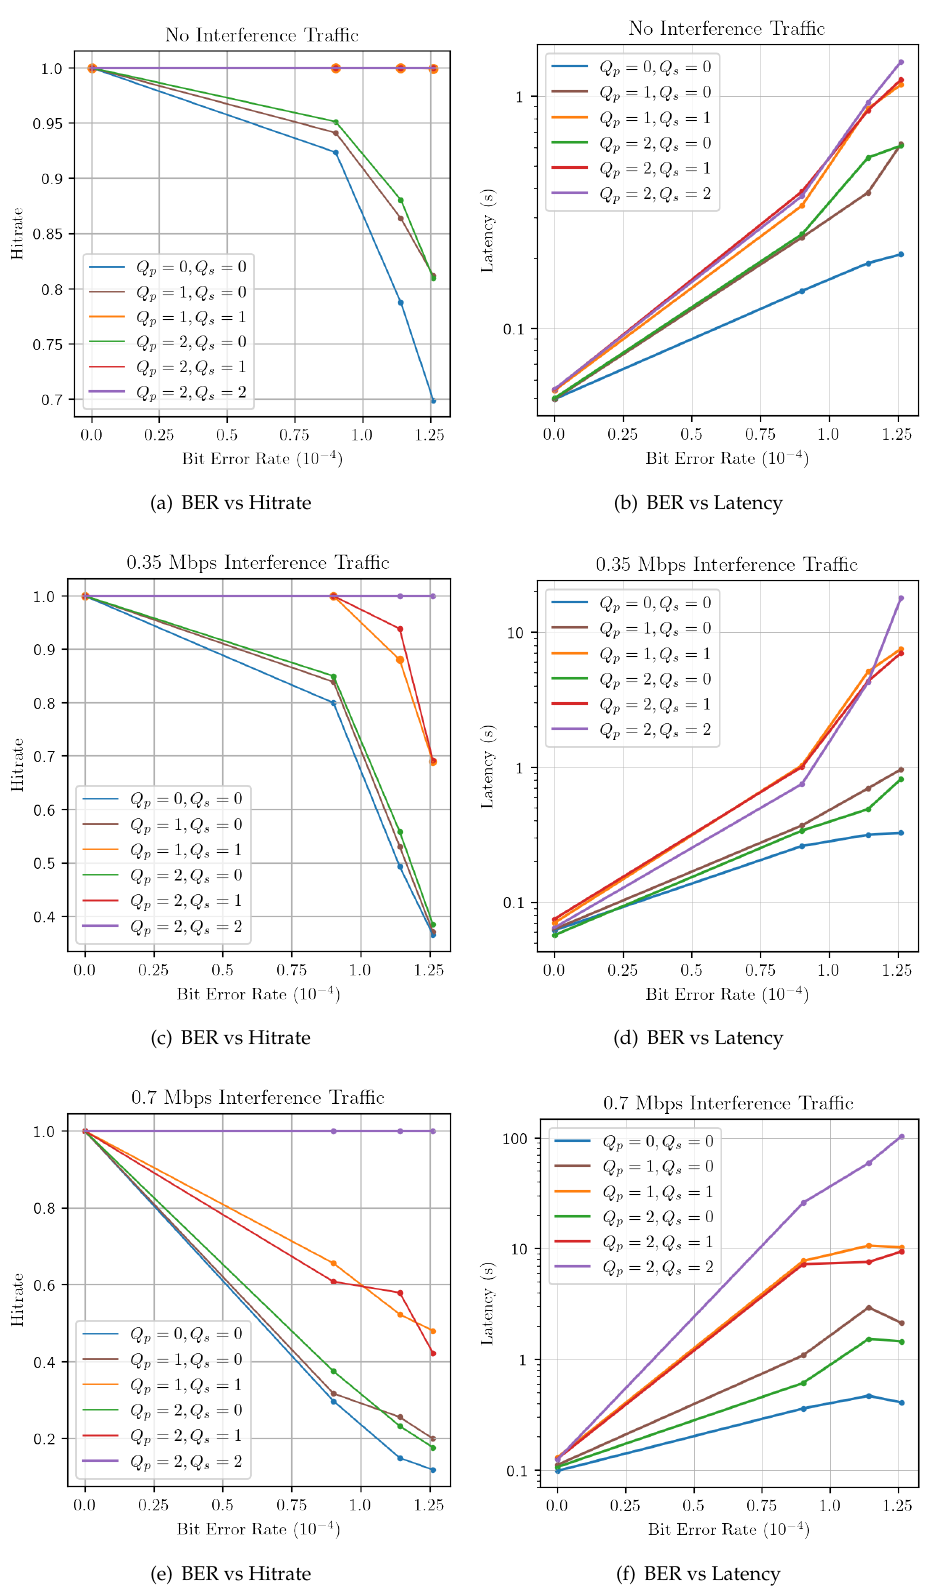
Figure 3. Average hitrate ( left ) and latency ( right ) for all publisher/subscriber QoS combinations under different network conditions (varying BER and Interference